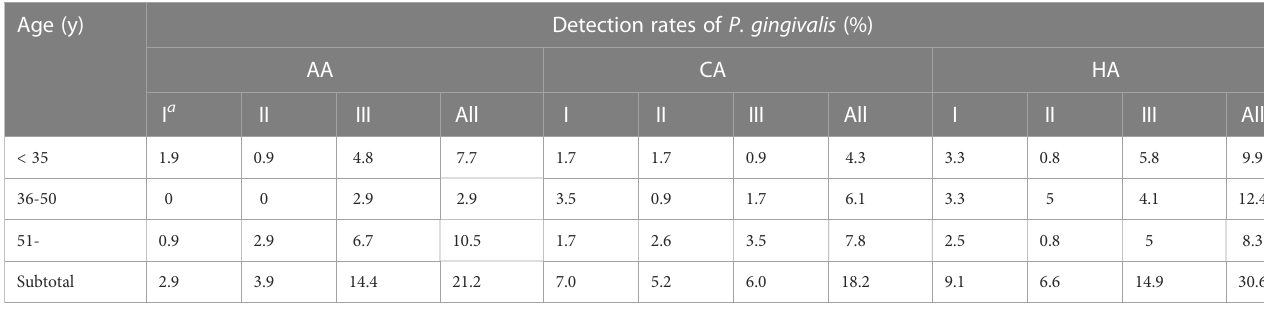
TABLE 4 Prevalence of P. gingivalis in participants of different ages and racial/ethnic groups. Age (y) Detection rates of P. gingivalis (%) AA CA